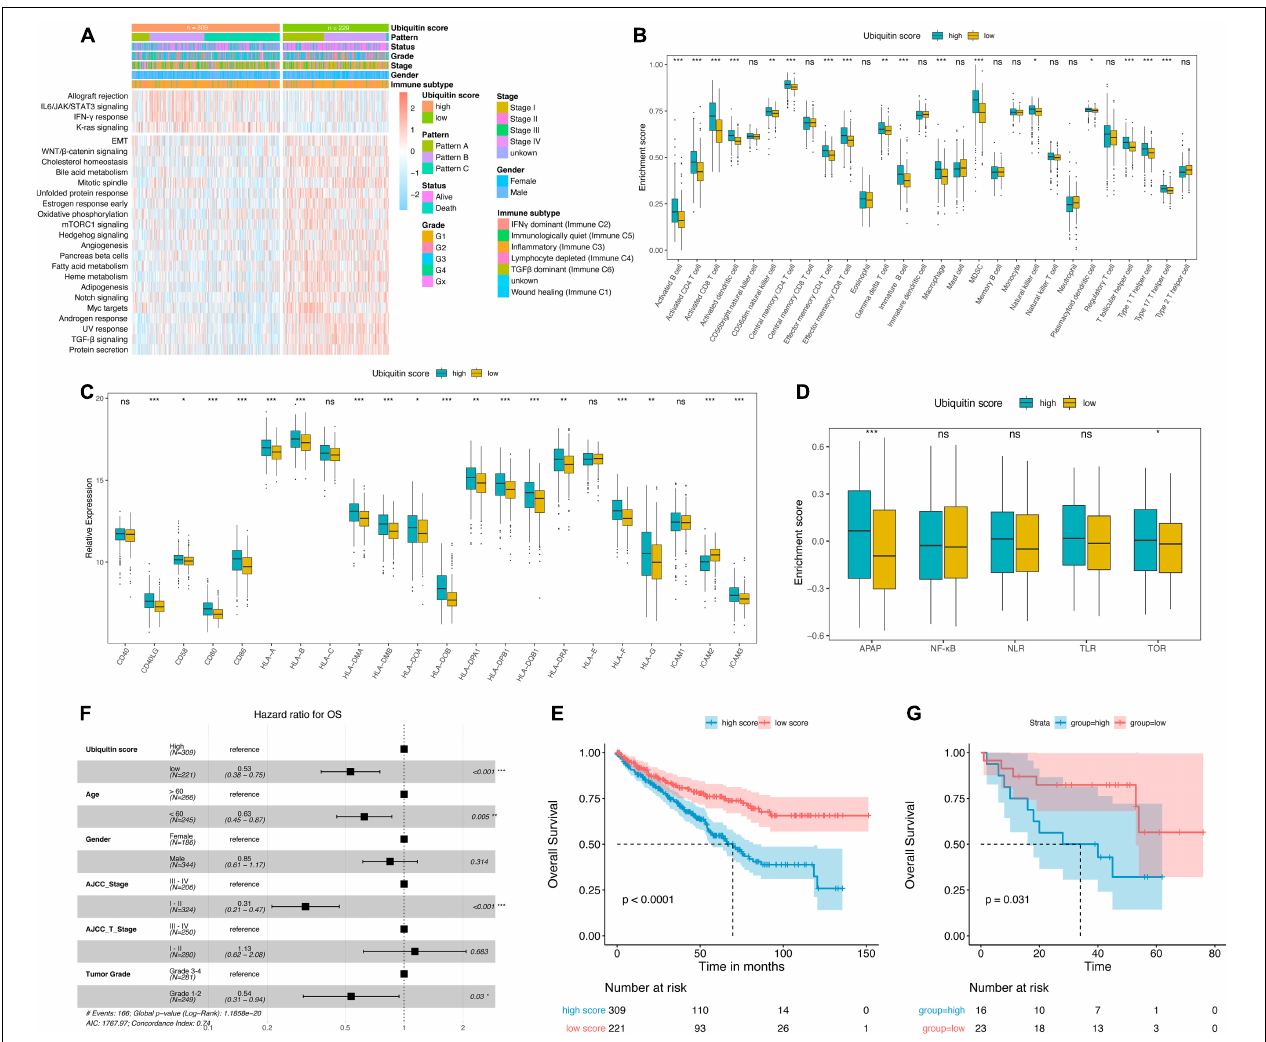
FIGURE 5 | Characterization the ubiquitin score groups and prognosis analysis. (A) Hallmark pathways of ubiquitin score group determined by GSVA enrichment, | logFC| > 0.1. (B) Immune infiltration landscape, Wilcoxon test. (C) Relative expression of MHC molecules, co-stimulatory molecules, and adhesion factors, Wilcoxon test. (D) Enrichment scores of immune activation-related signatures, Wilcoxon test. APAP, antigen processing and presenting, NLR, NOD-like receptor signaling pathway, TLR, Toll-like receptor signaling pathway, TCR, T-cell receptor signaling pathway. (E,G) Kaplan-Meier curves of overall survival (OS) in TCGA (E) and GSE29609 (G) cohorts, Log-rank test. (F) Multivariate cox analysis adjusted by age, gender, tumor stage, T-stage, and tumor grade showed that ubiquitin score was an independent risk factor for OS. * p < 0.05, ** p < 0.01, *** p <